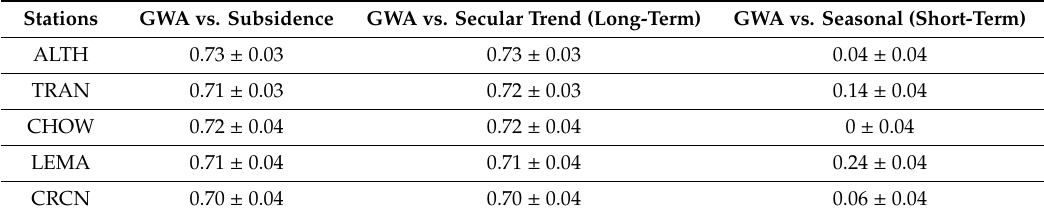
Figure 12. Comparison of the Gravity Recovery and Climate Experiment satellite (GRACE)‐derived groundwater anomaly (GWA), representative vertical subsidence time history, and PRISM precipitation variation with time. The GWA from combined San Joaquin Valley Basin (SJ) and Tulare basin (TU) are plotted with associated uncertainties. GWA from SJ or TU has very similar temporal variation; thus is not shown for legibility. The semi‐transparent gray shaded areas indicate 2006–2010 and 2012–2016 drought periods with GWA trending lines (black dashed), respectively. The vertical subsidence time series are derived from the LOS displacement time series at the location of TRAN (blue circles—GPS; red dots—InSAR). The magenta dashed line in late 2015 indicates the time when the GWA starts to recover due to increased surface precipitation and groundwater recharge or reduced pumping while the blue dashed line in late 2016 is the time of secular subsidence cessation. Table 2. Correlation between groundwater anomaly (GWA) and line-of-sight (LOS) subsidence (short-term and